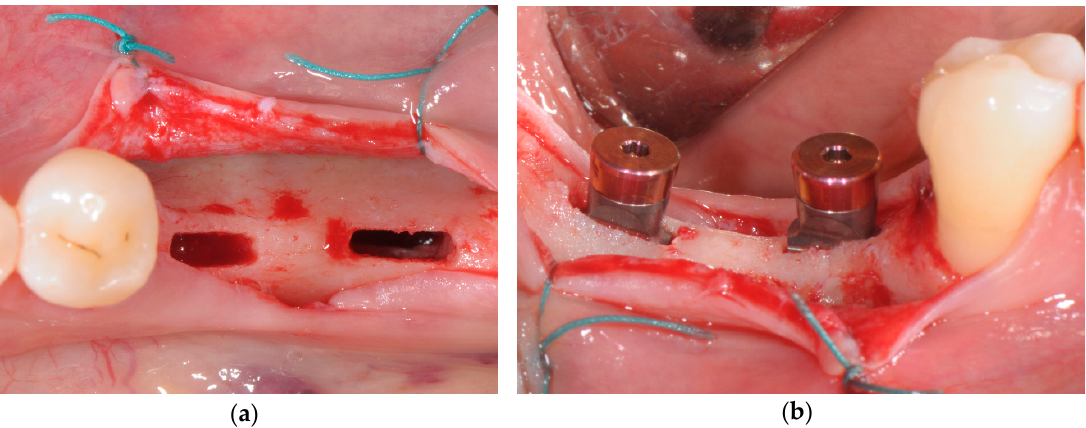
Figure 2. ( a ) Implant site preparation performed with piezoelectric tips; ( b ) wedge implants seating in the final position.